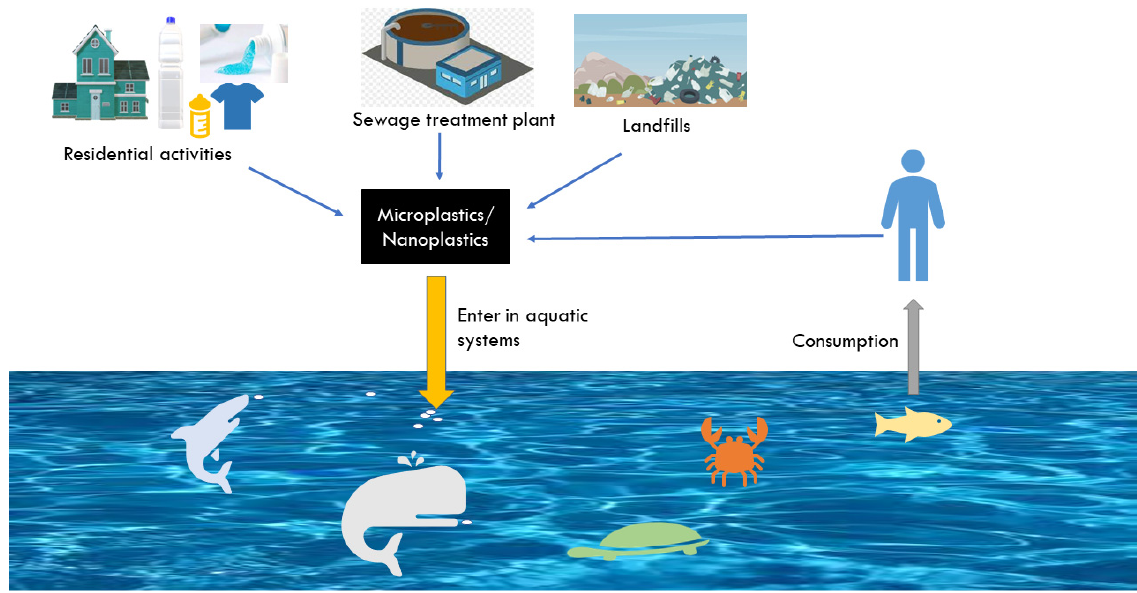
Figure 1. Life cycle of microplastics. Microplastics are produced from various sources, mainly anthropogenic in nature. Some of the examples are household activities, sewage treatments, landfalls, etc. Gradually, they enter into large water bodies and get accumulated in various habitats, which again come back to the human body via consumption of aquatic